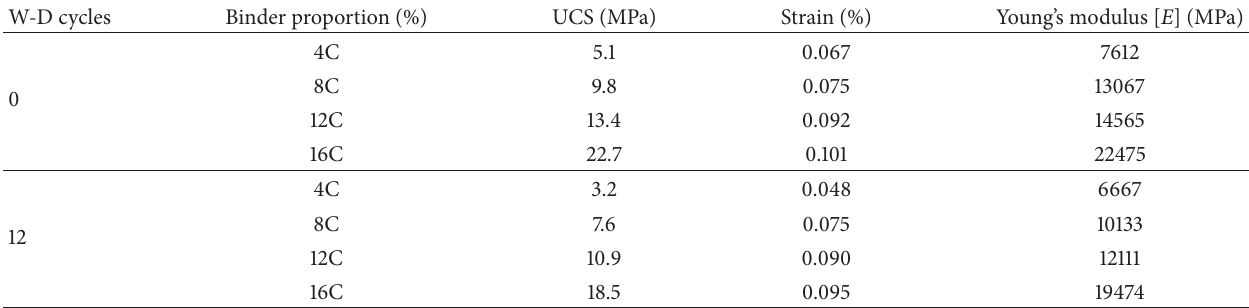
Table 9: Wet-dry cycles for cement stabilization.